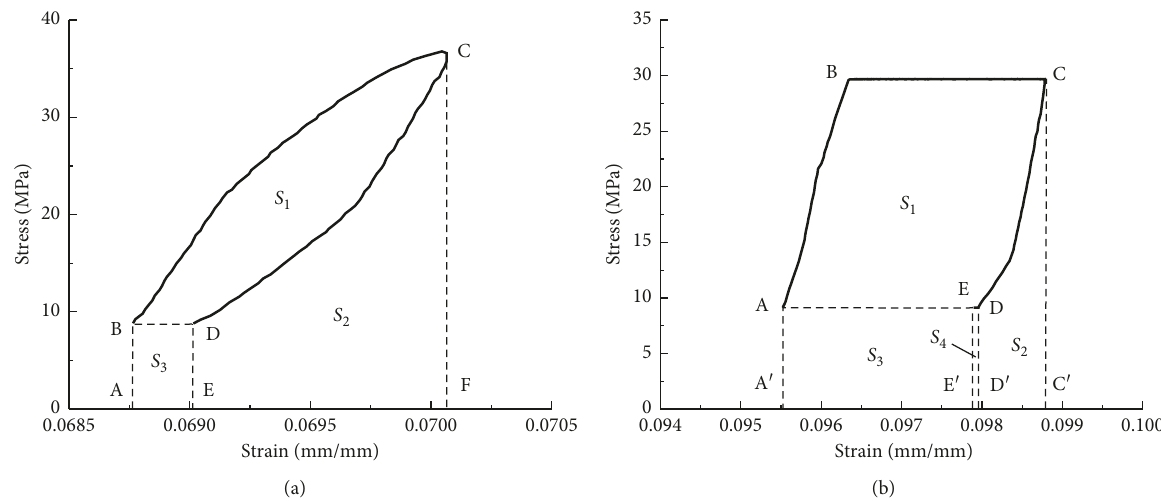
Figure 6: Typical hysteresis loop curve of rock salt. (a) The cycle number n n 15 of R 2 rock salt in the cyclic creep (cid:29)